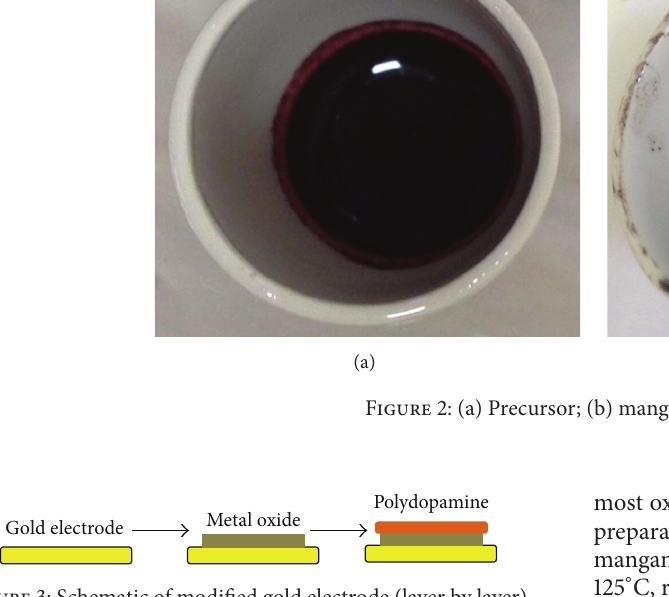
Figure 3: Schematic of modified gold electrode (layer by